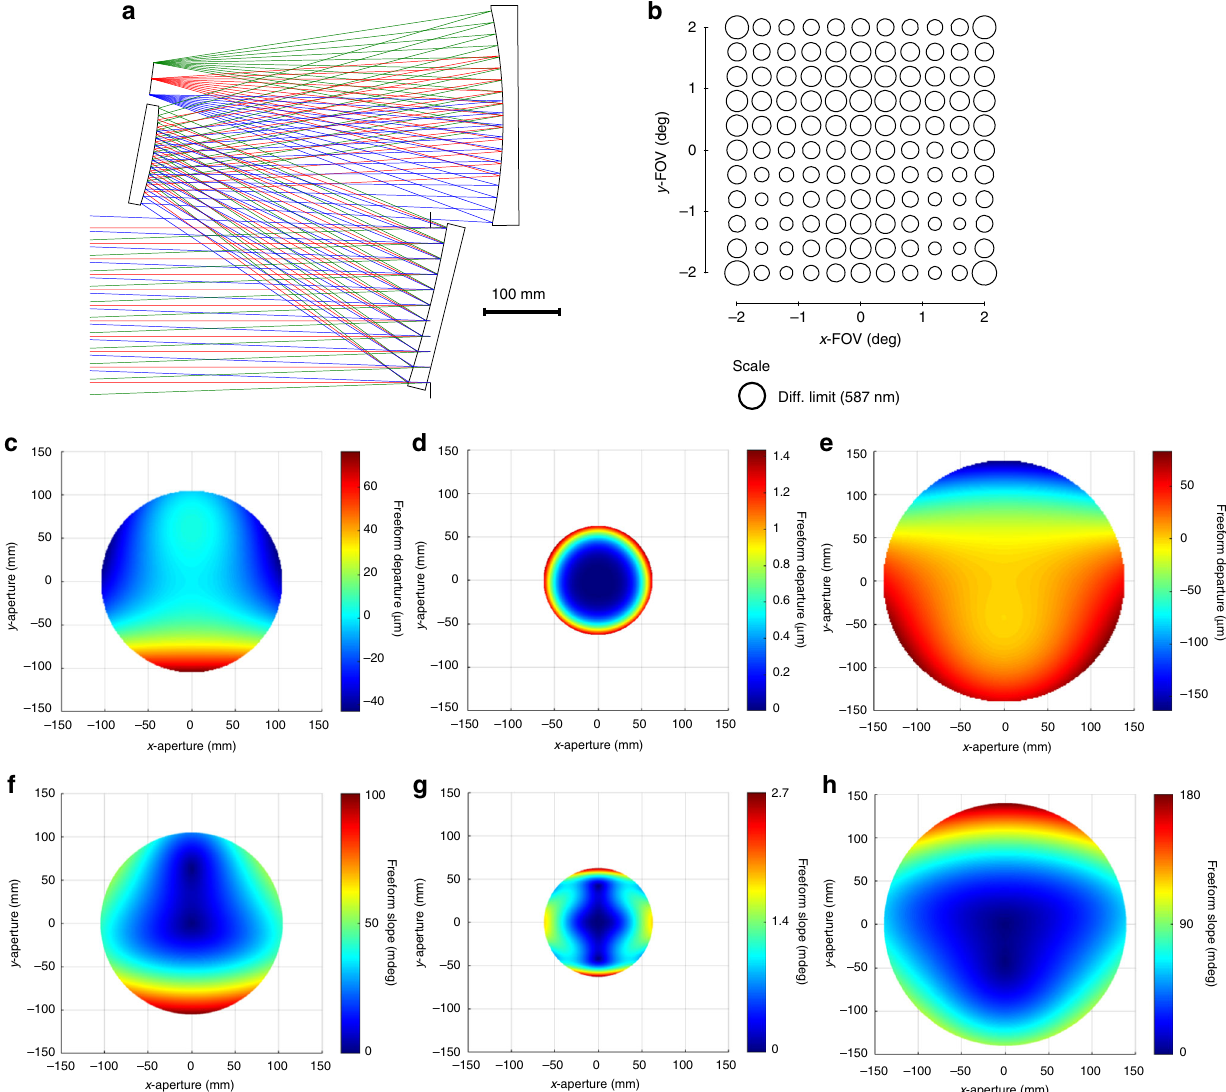
Fig. 8 Final design properties. a Layout of the fi nal design. The image plane is tilted by 1.8°. b Root-mean-square wavefront error (RMS WFE full- fi eld display (FFD for the fi nal design. All points across the FOV are diffraction limited. The peak-to-valley freeform departures from the base sphere for the c primary mirror, d secondary mirror, and e tertiary mirror are 122 μ m, 15 μ m, and 240 µ m, respectively. The gradient of the freeform departure for the f primary, g secondary and h tertiary mirrors are 0.10°, 0.0027°, and 0.18°,